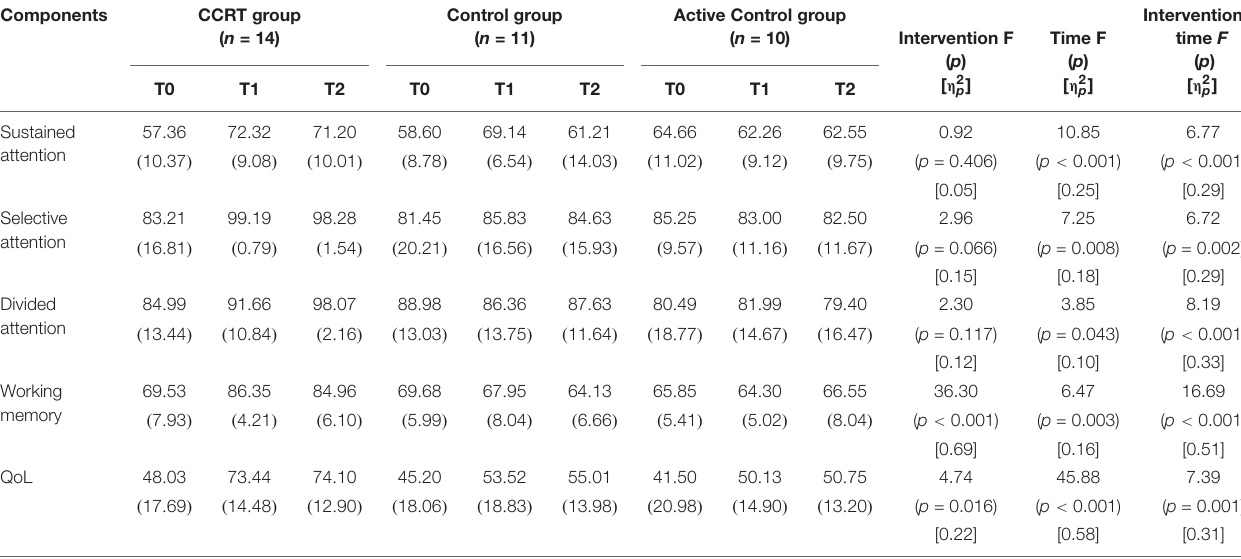
TABLE 2 | Summary of pre- and post-intervention and 6-month follow-up measures and significant interaction on repeated ANOVA. Components